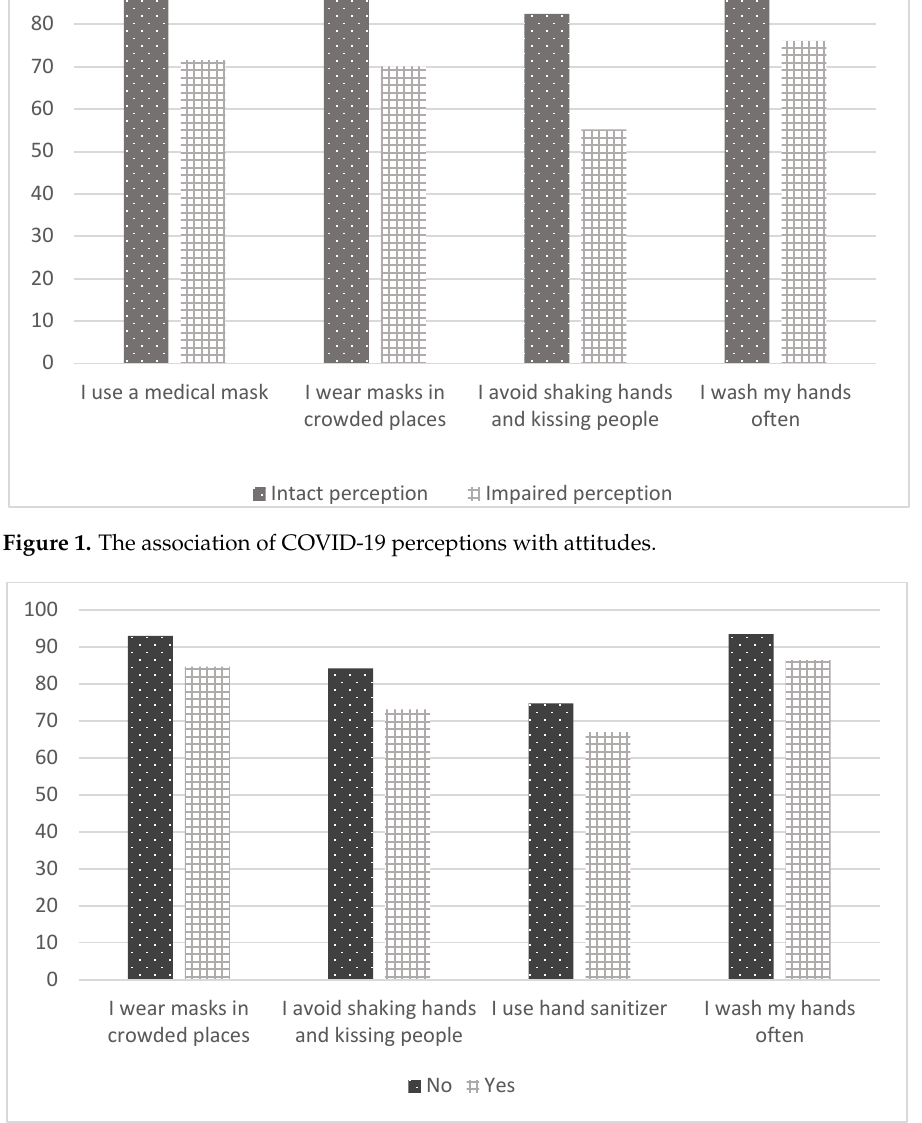
Figure 2. The association of conspiracy belief with attitudes.